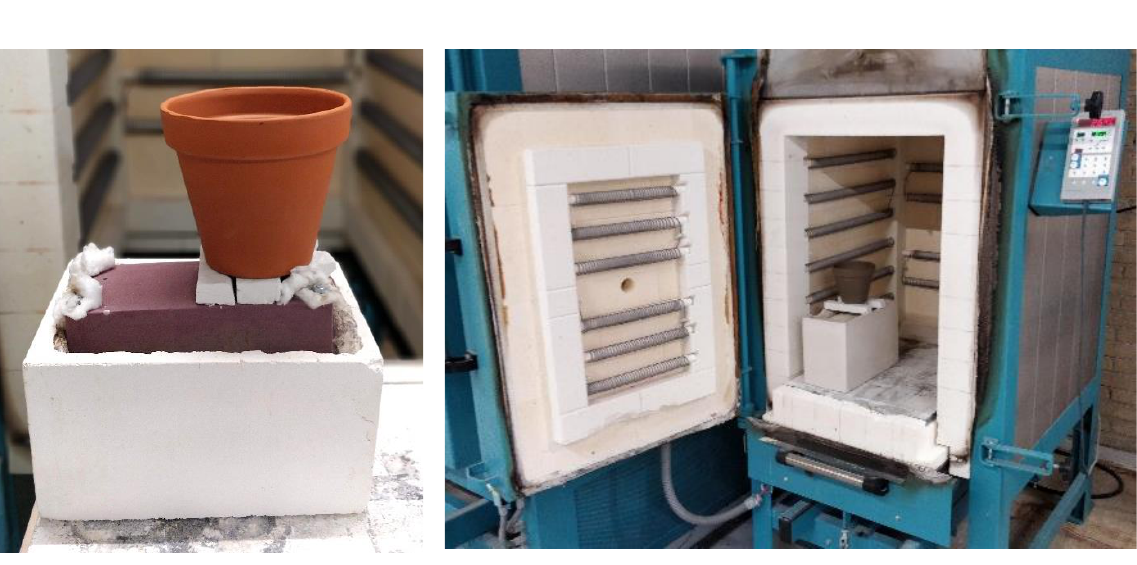
Fig. 10 Experimental set-up of the mould inside the kiln (left: Geometry 2, right: Geometry 3).